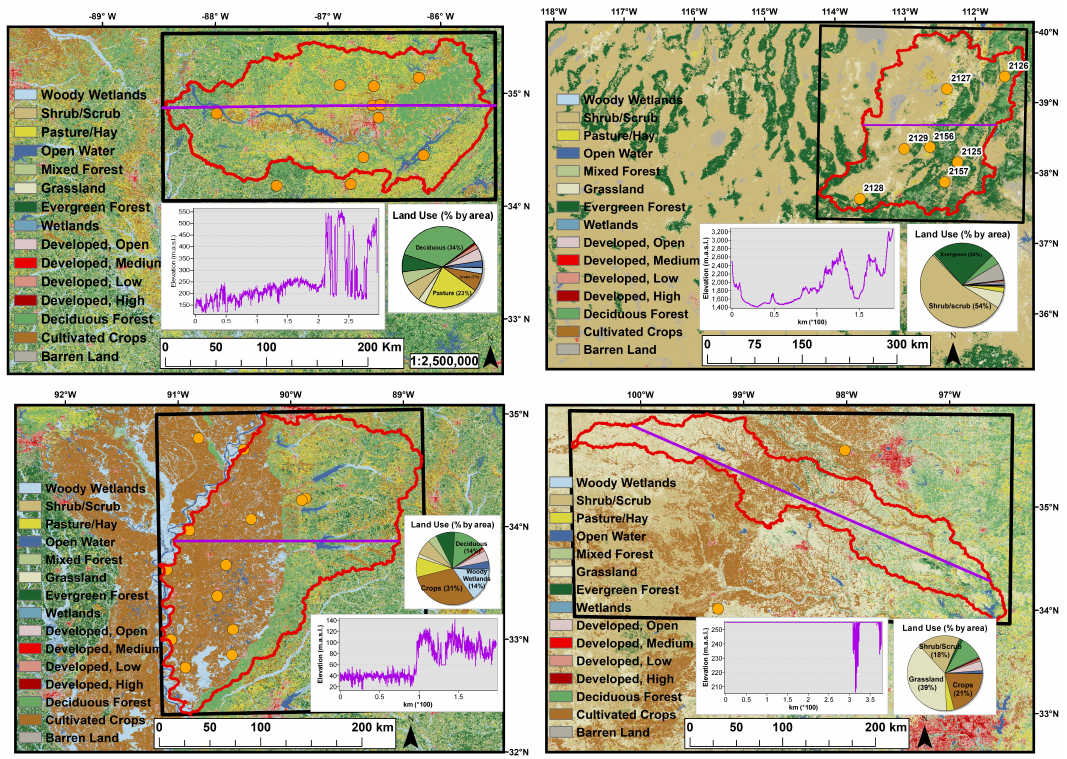
Figure 1. Study site land use (NLCD 2011), Soil & Climate Analysis Network (SCAN) stations (orange), and elevation profile (purple) for (clockwise from top left) Elk river watershed (ELKR), Yazoo (YAZO), Washita (WASH), and Escalante-Sevier Lake (ESCL). The red curves outline each